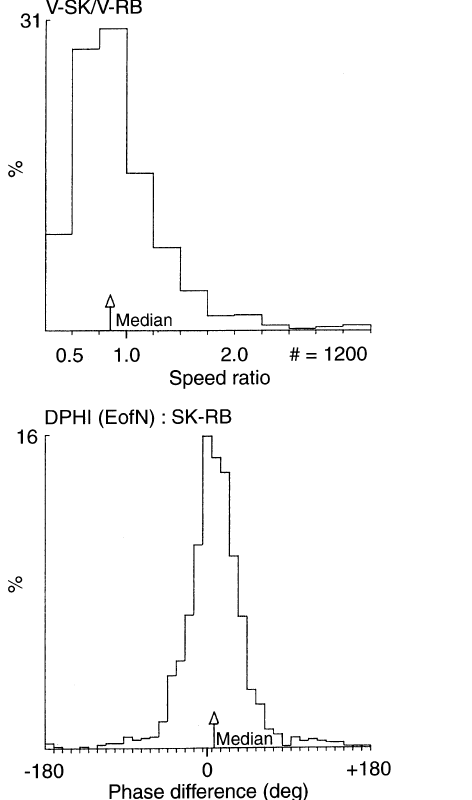
Fig. 3. Speed-ratio and direction-di(cid:128)erence histograms comparing Robsart (49 (cid:14) N, 109 (cid:14) W) and Saskatoon (52 (cid:14) N, 107 (cid:14) W) MFR data: data from 82–94 km, Jan 1–Feb 18, 1996, hourly means with #